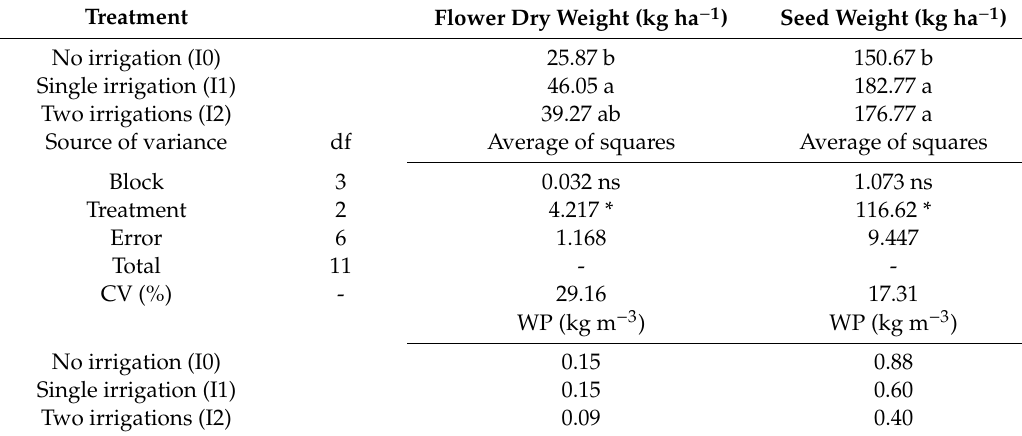
Table 5. European borage productivity and ANOVA results in